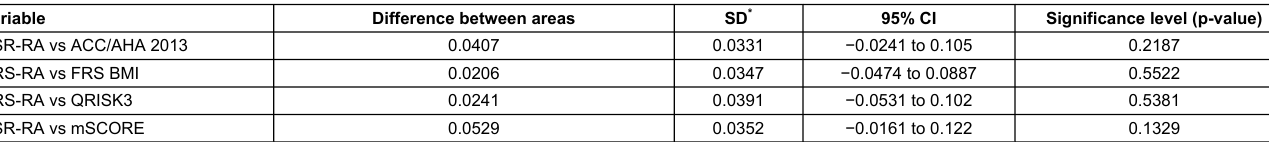
Table 4: Comparison of the Expanded Risk Score in Rheumatoid Arthritis area under the receiver operating characteristic curve to the areas of the other four cardiovascular risk prediction scores.